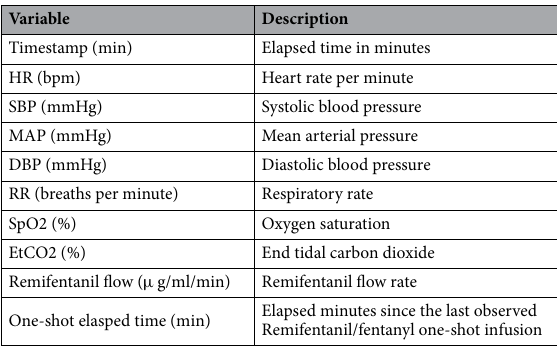
Table 4. Details of collected data